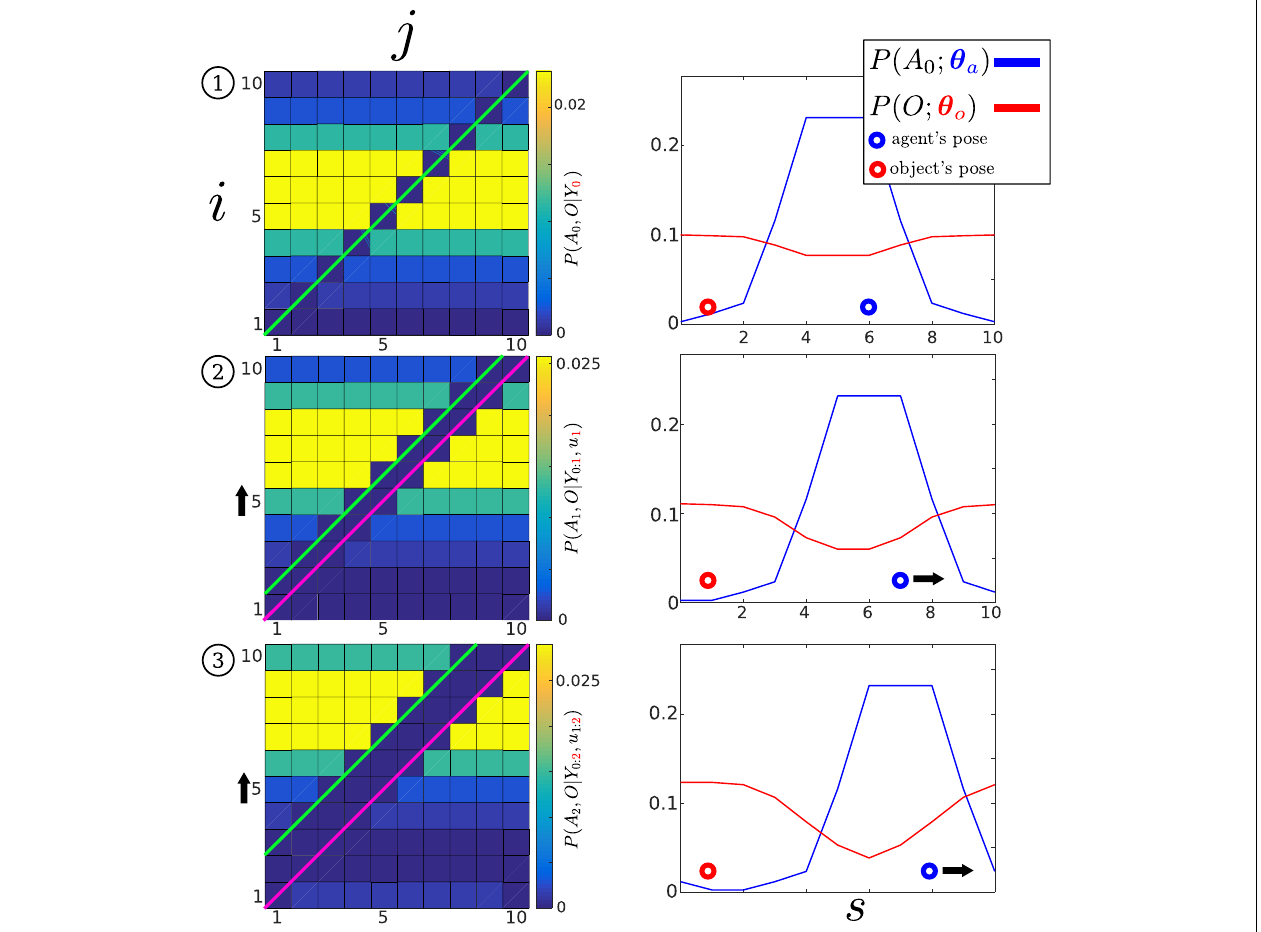
FIGURE 5 | Histogram-SLAM, 4 time steps. (1) Application of likelihood P ( Y 0 = 0| A 0 , O ) and the agent remains stationary, all states along the green line become zero. (2) The agent moves to the right u 1 = 1, the motion P ( A 1 | A 0 , u 1 ), and likelihood models are applied consecutively. The right motion results in a shift (black arrow on the left) in the joint probability distribution toward the state i = 10. All parameters on the pink line are zero. (3) Same as two. At each time step, a new likelihood function (pink line) is applied to the joint distribution.